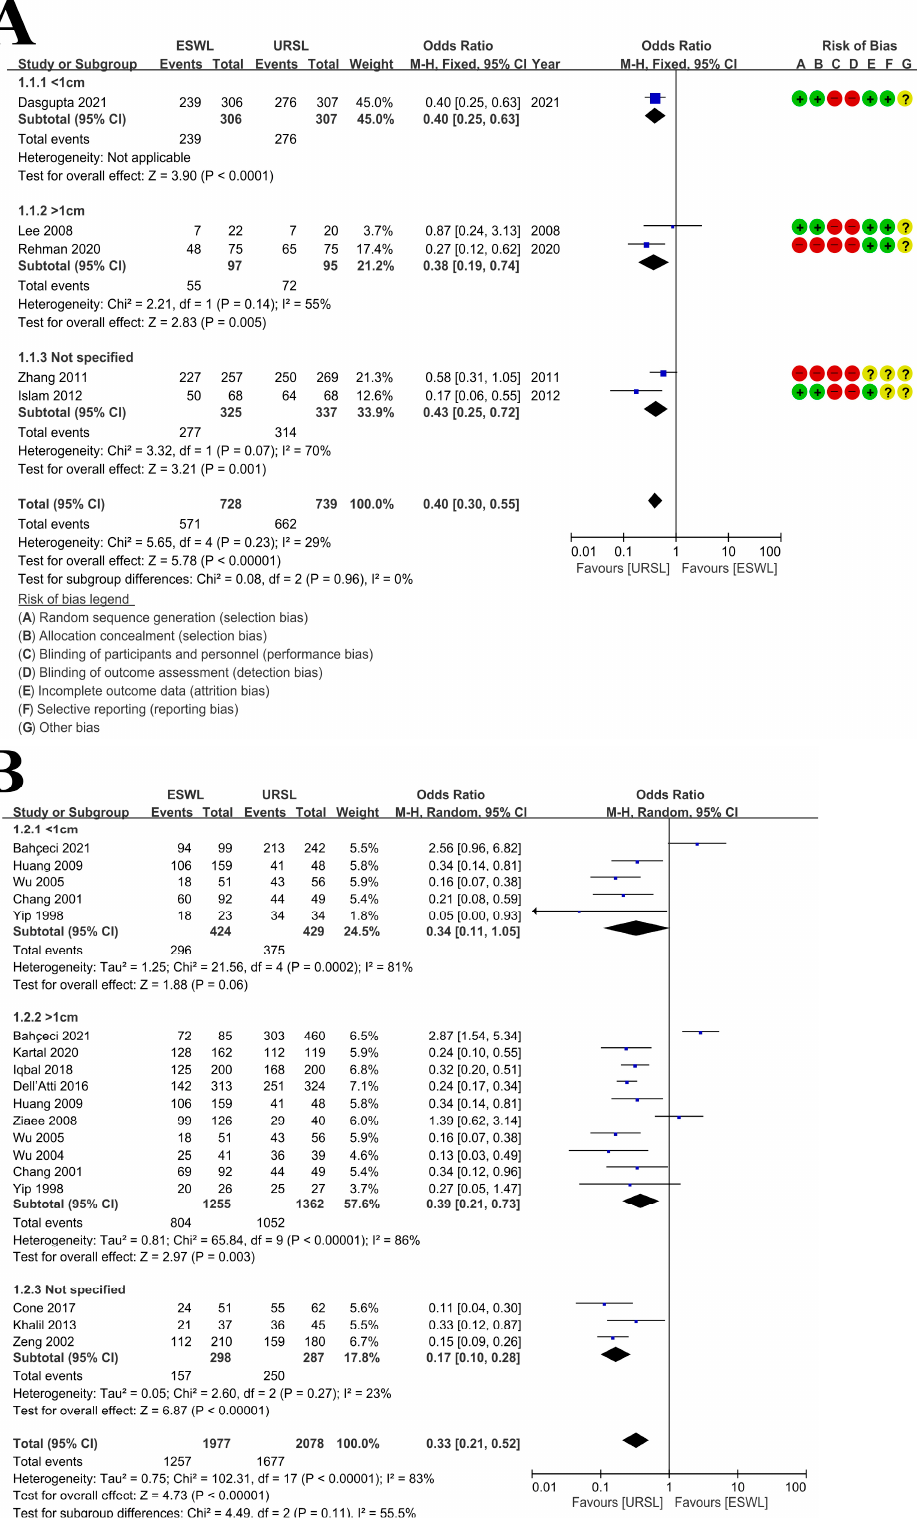
Figure 2. Funnel plot: ( A ) Stone-free rate (SFR) in randomized controlled trials (RCTs), ( B ) SFR in non-RCTs, ( C ) Retreatment.